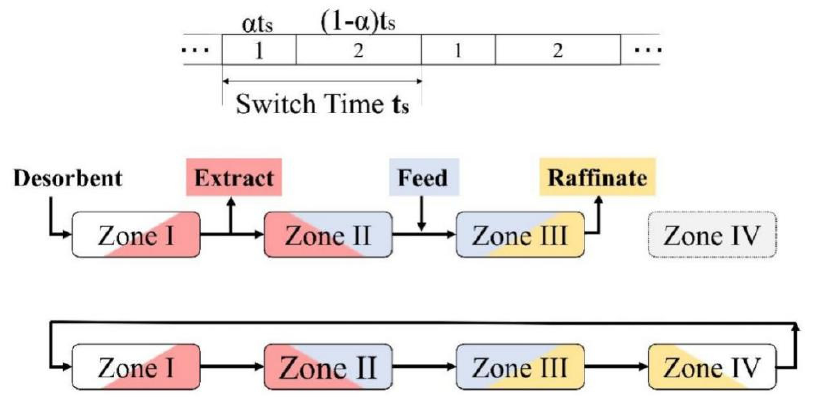
Figure 13. Schematic diagram of the ISMB process with port switching occurring at the end of Step 2 and the beginning of Step